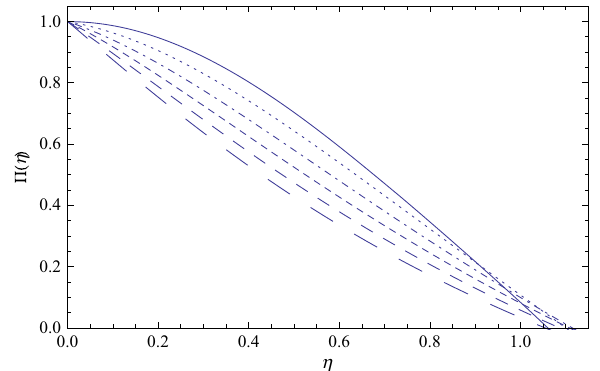
Fig. 1 Variation of the dimensionless pressure (cid:19) as a function of the dimensionless radial coordinate η for a constant density star in dRGT massive gravity theory for ψ = 0 . 06, and different values of σ : σ = 0 . 25 (dotted curve), σ = 0 . 50 (dashed-dotted curve), σ = 0 . 75 (short dashed curve), σ = 1 (dashed curve), and σ = 1 . 25 (long dashed curve). For the sake of comparison we have also presented the standard generalrelativisticcase,correspondingto ψ = σ = 0(solidcurve).The boundary condition used to integrate the TOV equation are (cid:19)( 0 ) = 1, and (cid:19)(η s ) = 0, respectively